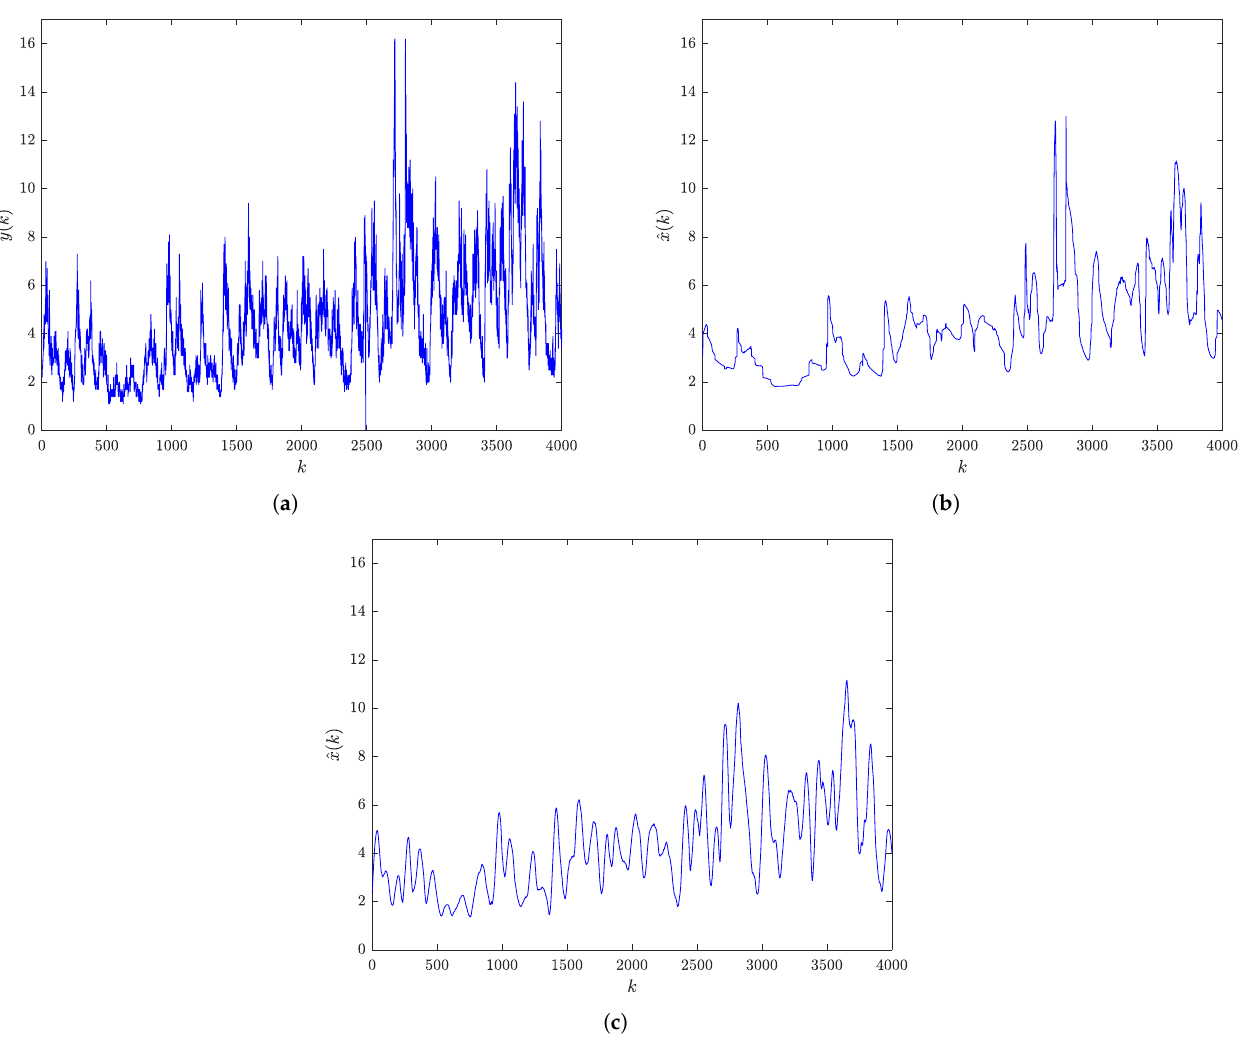
Figure 12. Individual maximum wave height: ( a ) Noisy measured signal. ( b ) RBF-RICI filtered signal.( c ) Savitzky–Golay filtered